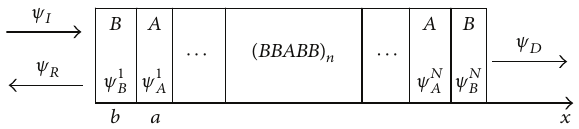
Figure 1: The QW structure of 1D PCs.